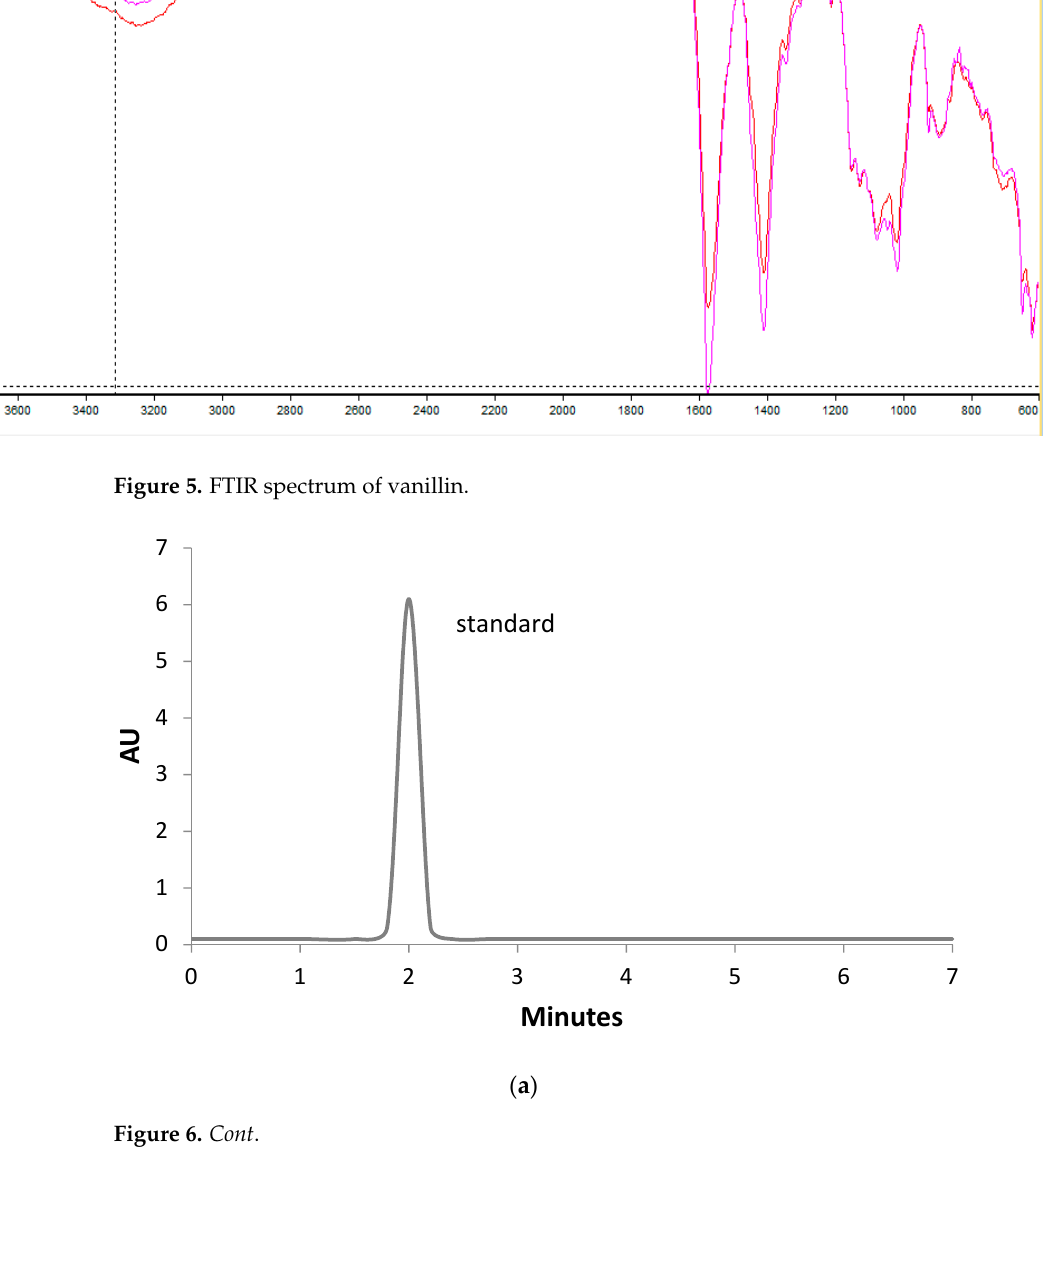
( b ) Figure 6. HPLC chromatogram of biovanillin ( a ) standard ( b ) sample. SSF allows the use of industrial processing residues as a substrate that helps to minimize pollution problems. It doesn’t require agitation, and therefore the production cost can be minimized compared to submerged fermentation. In the current research, maximum biovanillin yield (0.462 mg/g) from Punica granatum peels was achieved at 60% moisture content, 2 mL inoculum size, 6.5 pH, and 32 °C temperature using SSF. Ferulic acid is the ideal precursor for vanillin production due to its structure similarity. For fer- ulic acid transformation, five pathways have been reported, namely (1) coenzyme A de- pendent deacetylation, (2) coenzyme A independent deacetylation, (3) non oxidative decarboxylation, (4) oxidative coupling, and (5) side chain reduction. The non-oxidative decarboxylation pathway has been detected in many yeasts, fungi and in a few bacteria. This pathway was catalyzed by decarboxylase enzyme, which converted the ferulic acid into 4-vinyl guaiacol. CoA independent deacetylation pathways have been investigated in Fusarium solani , Pseudomonas mira and Streptomyces setonii , which yielded vanillin by the removal of acetate moiety from the ferulic acid side chain. Coenzyme A-dependent non- β -oxidative pathways for ferulic acid degradation have been reported in Pseudomo-